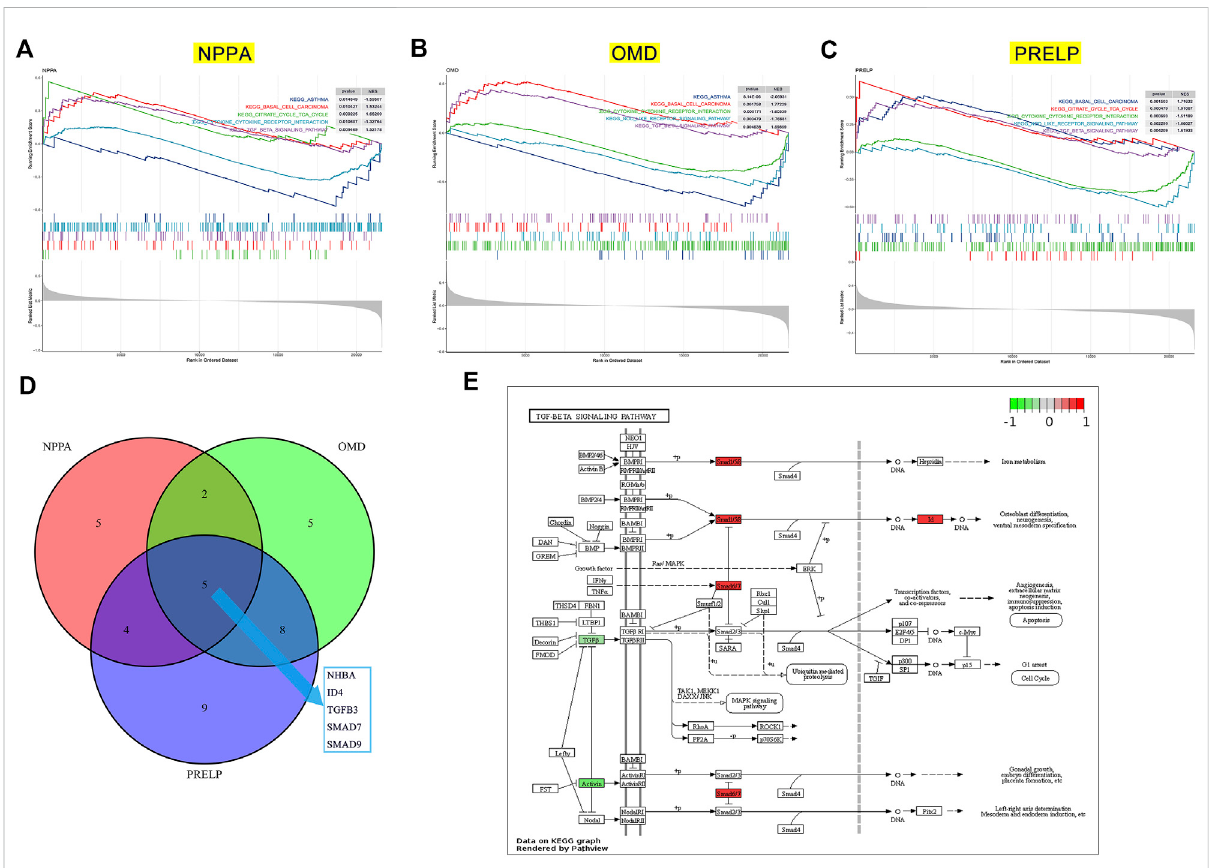
FIGURE 9 The potential pathway regulated by key genes in the development of DCM with HF. GSEA on low- and high-expression groups of NPPA (A) , OMD (B) ,andPRELP (C) . (D) IntersectionofTGF- β pathway genessigni fi cantlycorrelatedwith NPPA,OMD,andPRELP. (E) The relativeexpressionof INHBA, ID4, TGFB3, SMAD7, and SMAD9 in TGF- β signaling